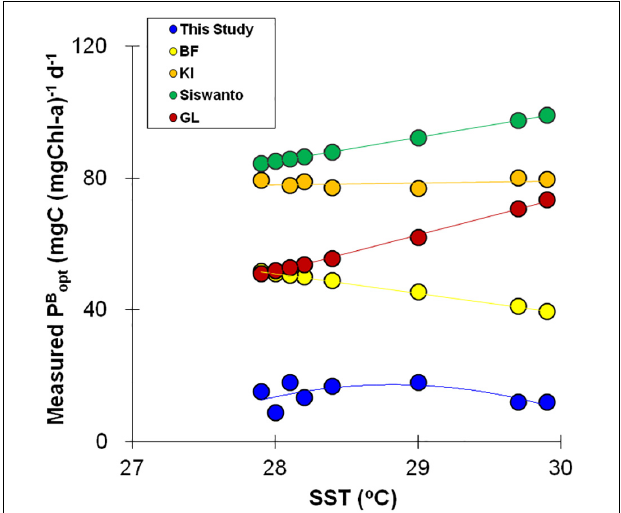
FIGURE 8 | Relationships between measured P B opt and SST. Circles, stars, diamonds, triangles, and squares indicate P B opt variations based on datasets of this study, models of Behrenfeld and Falkowski (1997a), Gong and Liu (2003); Kameda and Ishizaka (2005), Siswanto et al. (2006),